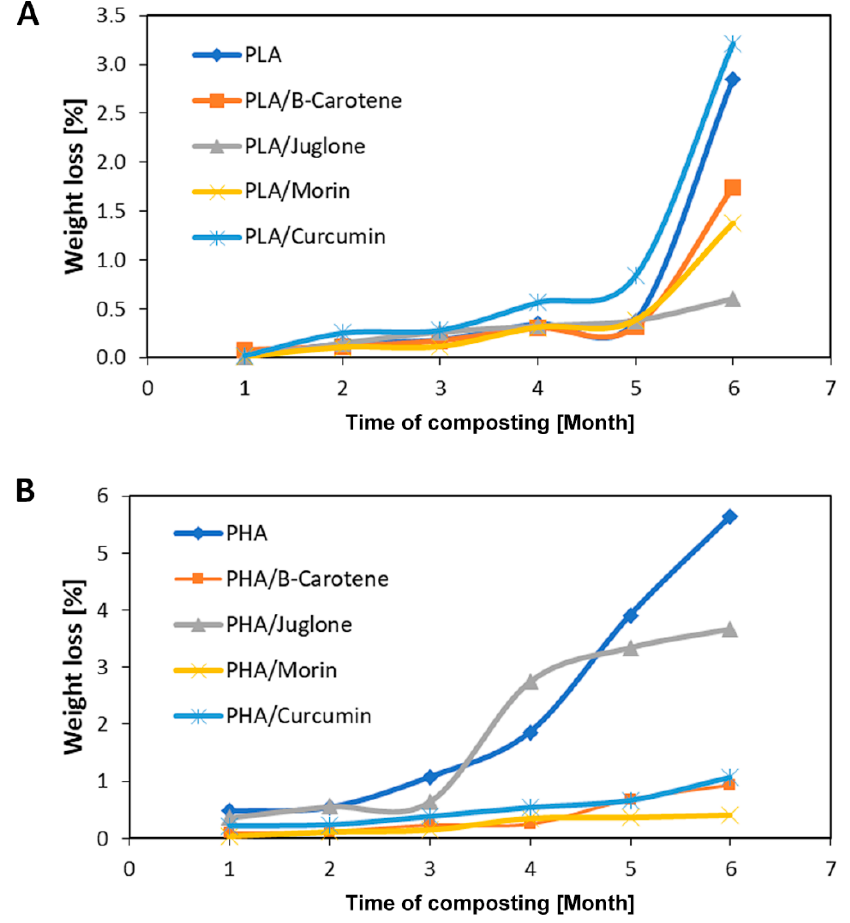
Figure 2. The weight loss of PLA ( A ) and PHA ( B ) samples over 6 months of composting.